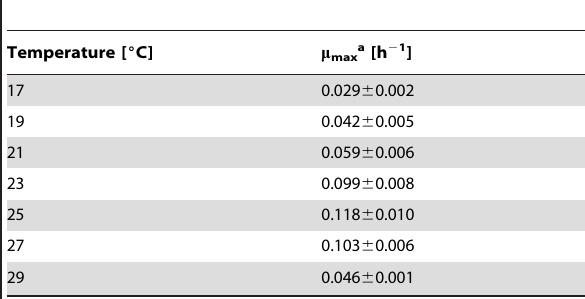
Table 3. Culture temperature impact on specific growth rate ( m max